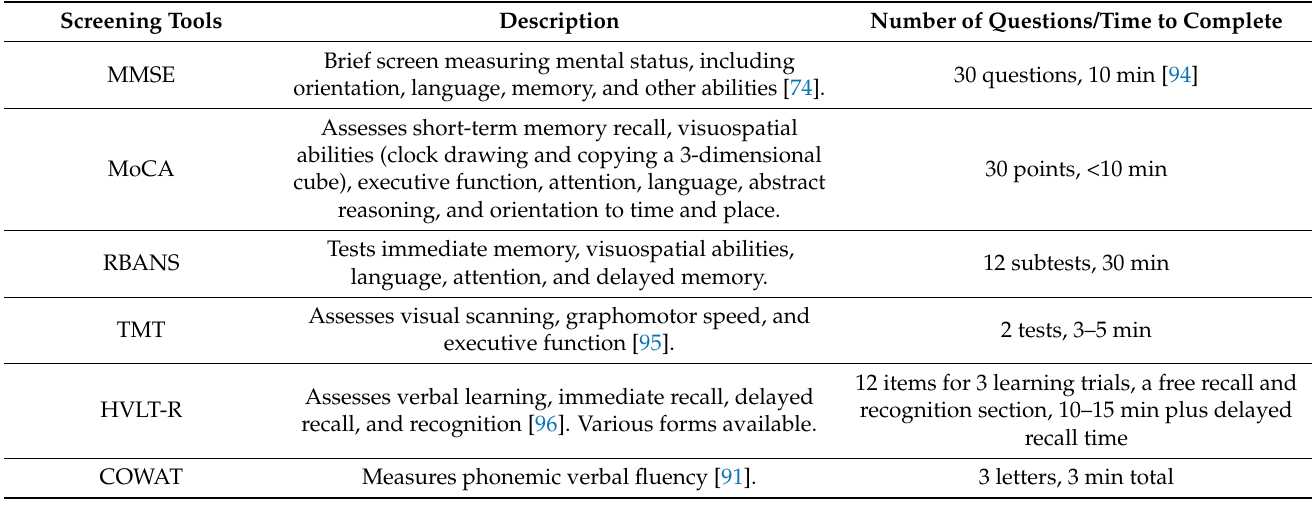
Table 2. Tools for measuring cognitive function in BM patients. Screening Tools Description Number of Questions/Time to